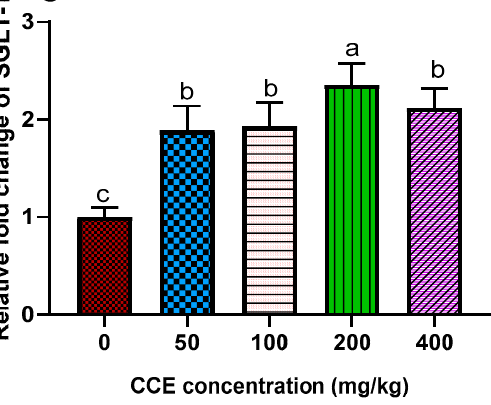
Figure 1. Effect of different levels of cornelian cherry extract (CCE) on glucose transporters genes expression (glucose transporter-1 ( A ) GLUT-1 , glucose transporter-2 ( B ) GLUT-2 , Sodium-dependent glucose transporter ( C ) SGLT-1 . a–d Means within the same column carrying different superscripts are significantly different at p < 0.05. Values are means ± standard error. Number of birds/replicates = 10